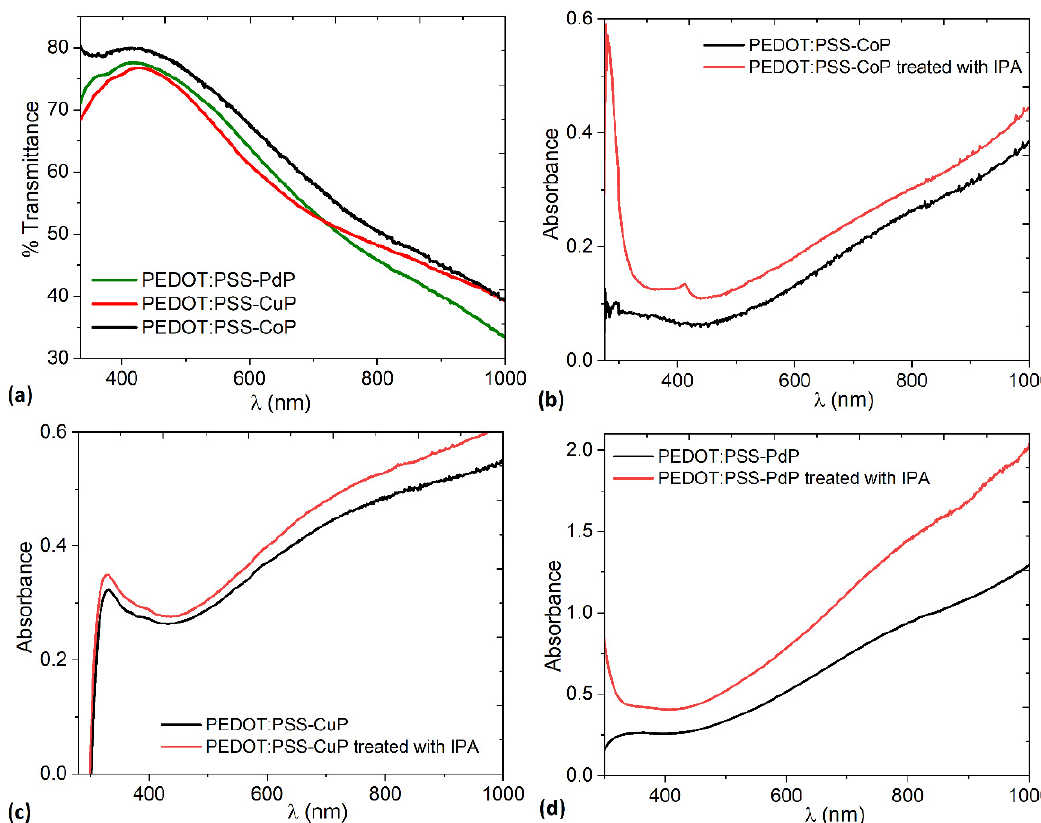
Figure 6. Spectral behavior of the ( a ) transmittance and absorbance for ( b ) PEDOT:PSS-CoP, ( c ) PEDOT:PSS-CuP, and ( d ) PEDOT:PSS-PdP films without and with IPA treatment.